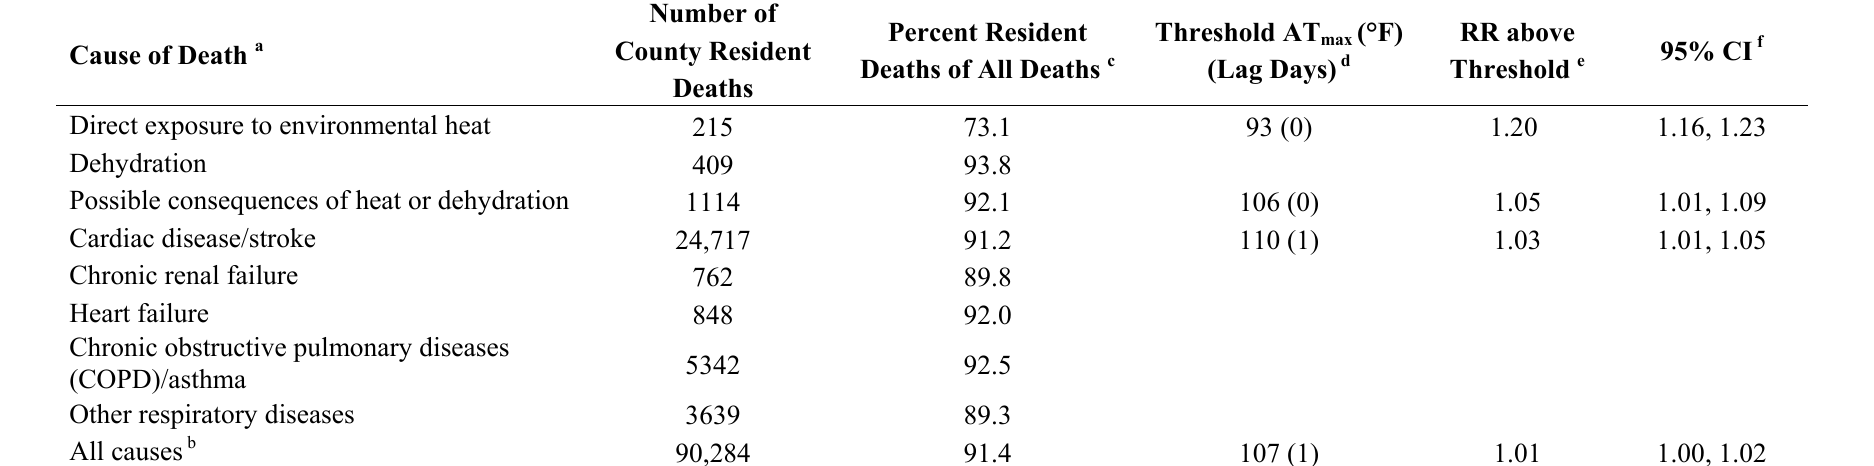
Table 2. Deaths in Maricopa County residents directly caused by exposure to environmental heat and other causes potentially related to high temperatures during the months May–October for years